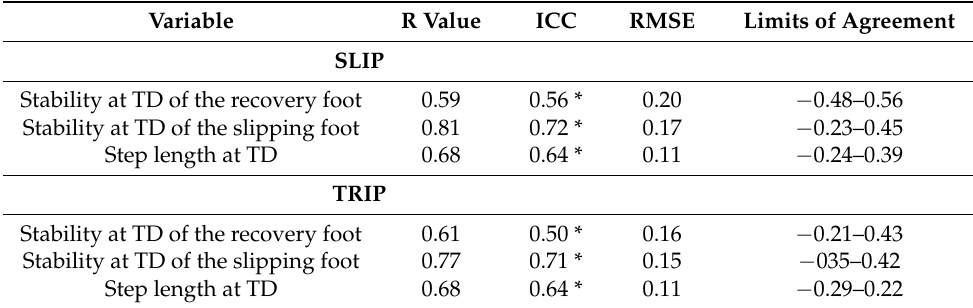
Table 1. Validity data of postural stability variables for slip–trip perturbation tests.